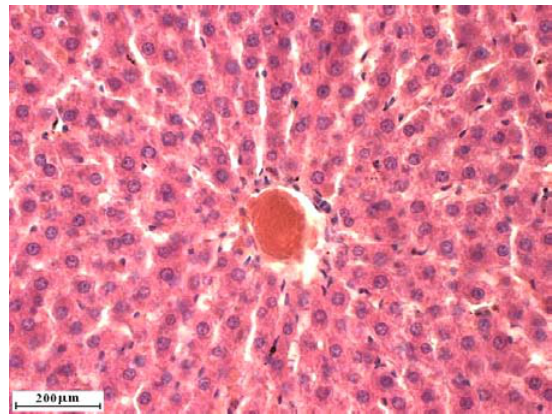
Figure 1. Liver cross section of rats treated with two doses of alloxan.